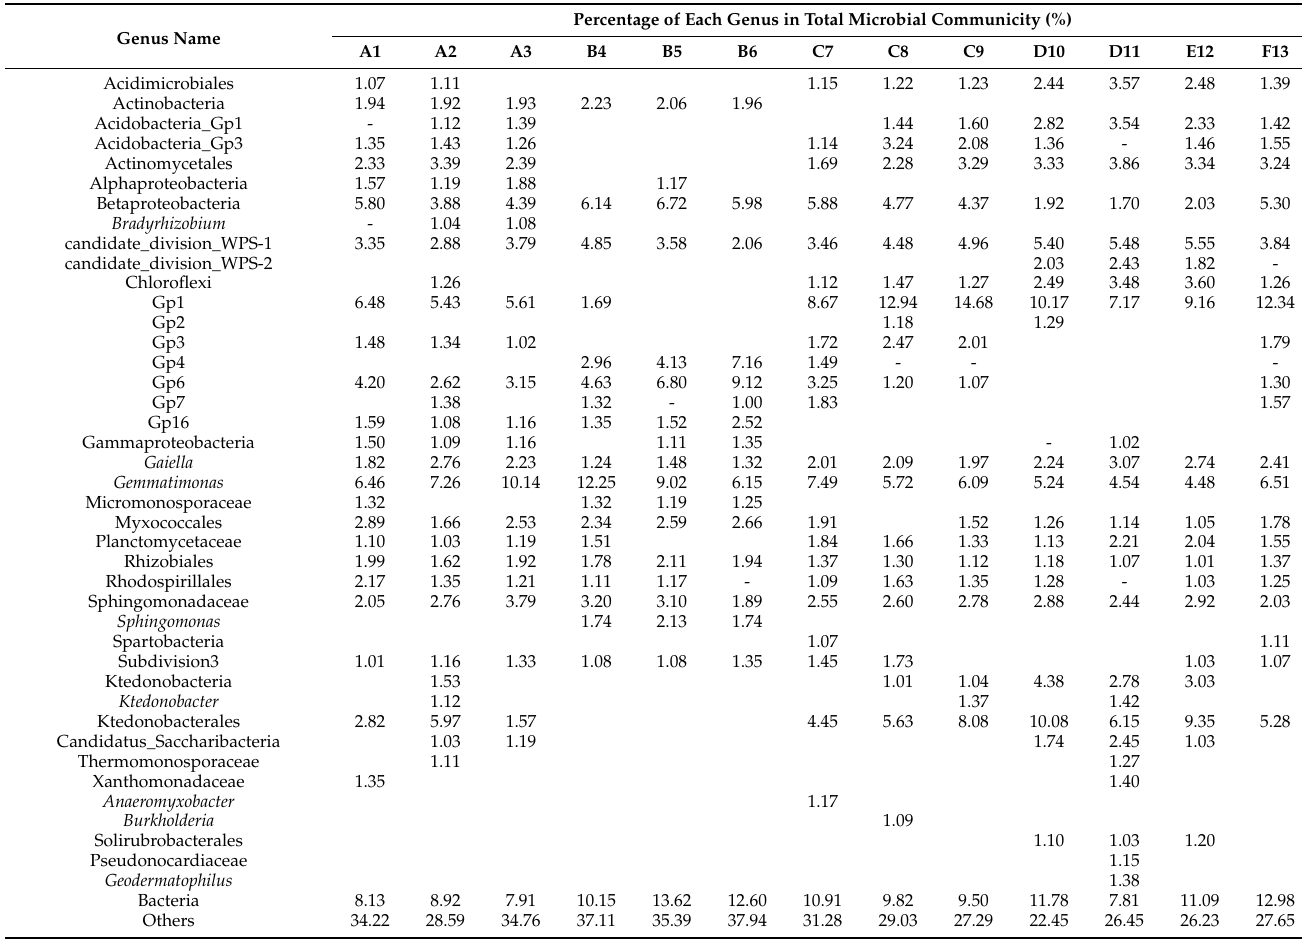
Table 6. Effect of different organic fertilizers and chemical fertilizer on the microbial composition of newly reclaimed soil. Genus